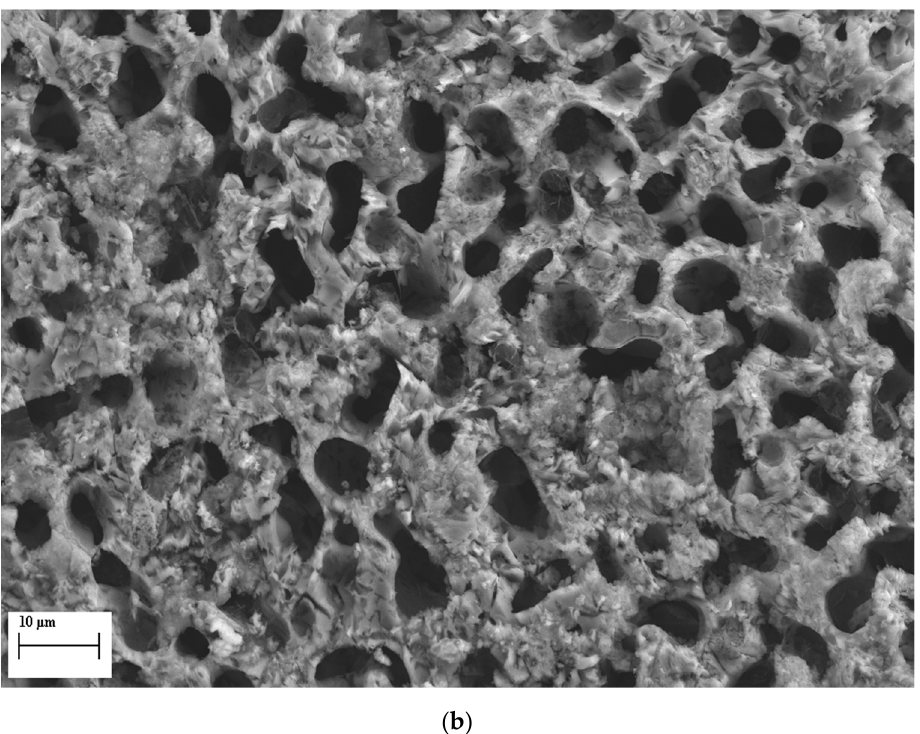
Figure 7. SEM image of a sample grown at 100 mm/h after soaking in the SBF solution for 28 days: longitudinal cross section ( a ) and disc surface ( b ).